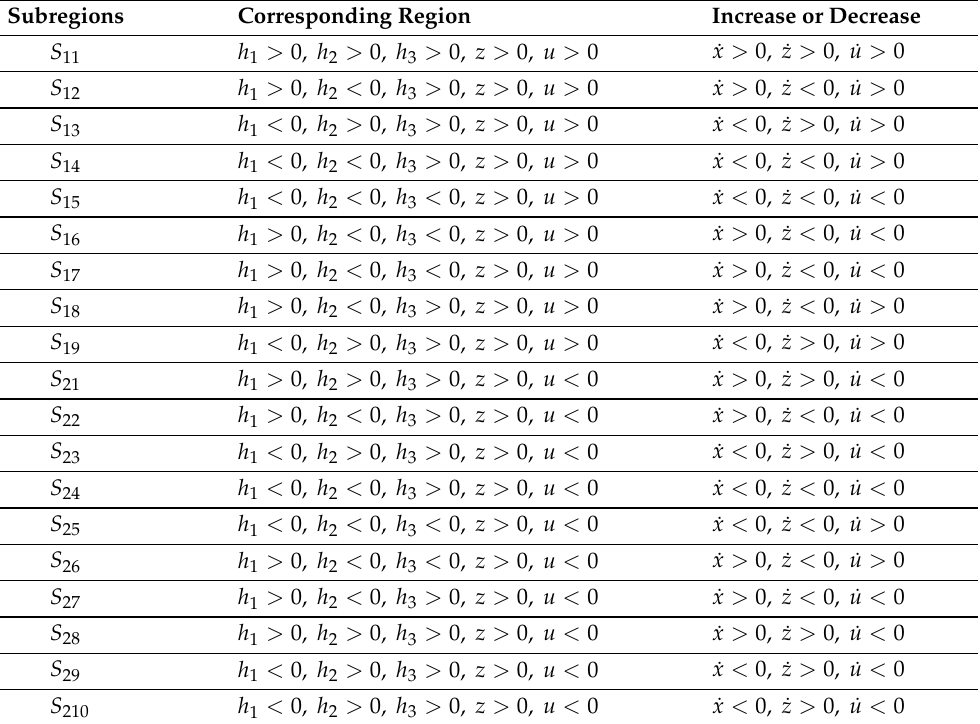
Table 9. Dynamical behavior in the nineteen